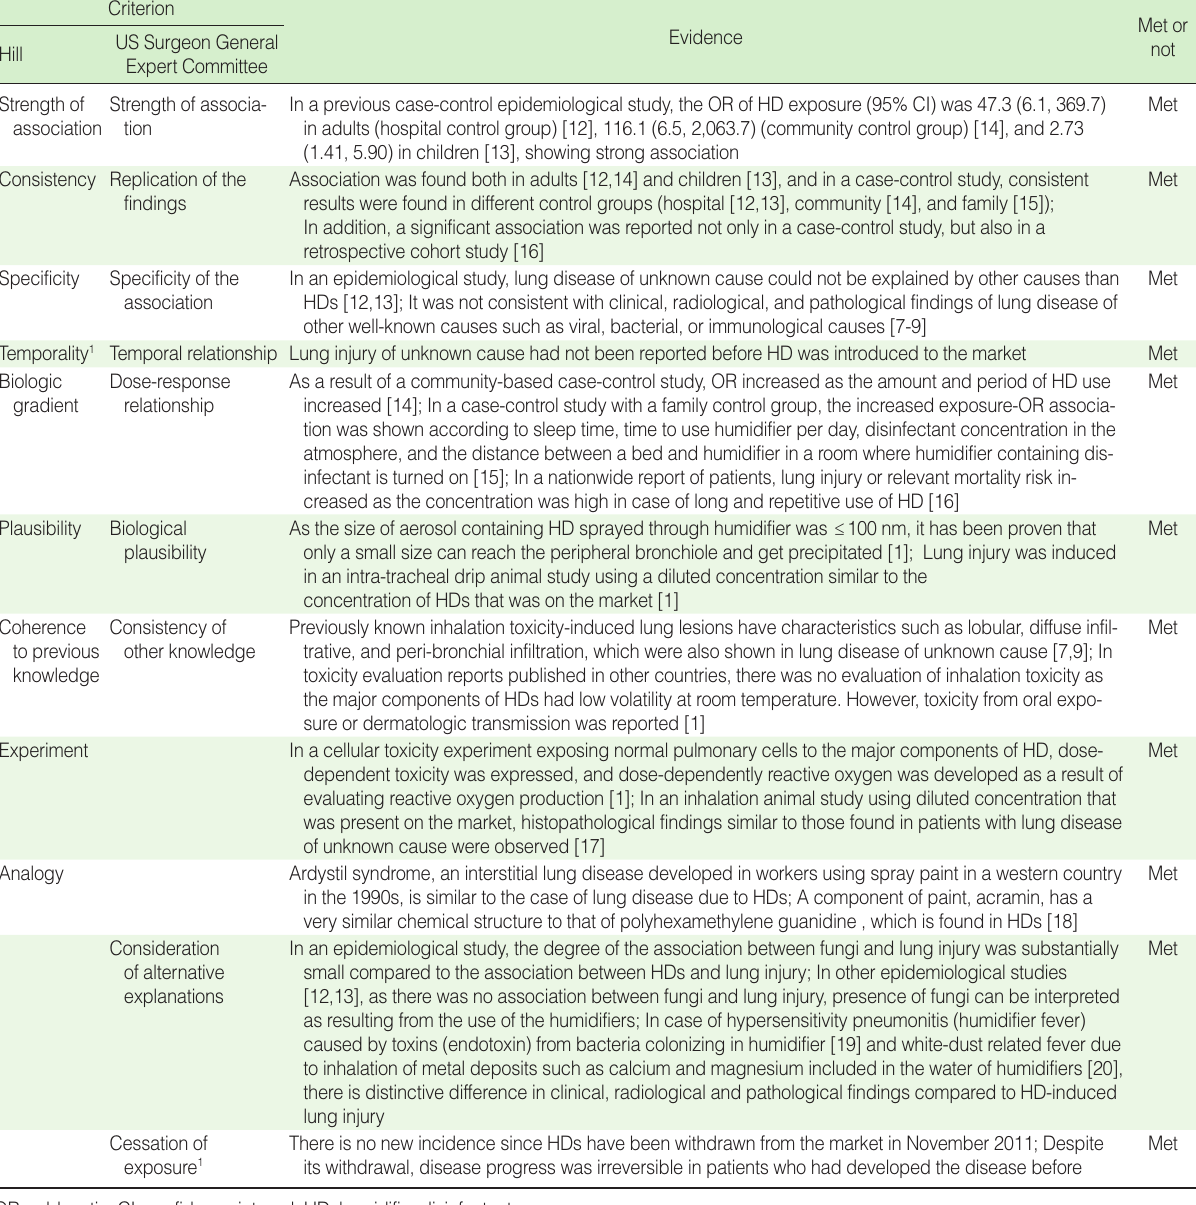
Table 2. Evaluation on the causality between humidifier disinfectants and lung injury based on Hill’s criteria